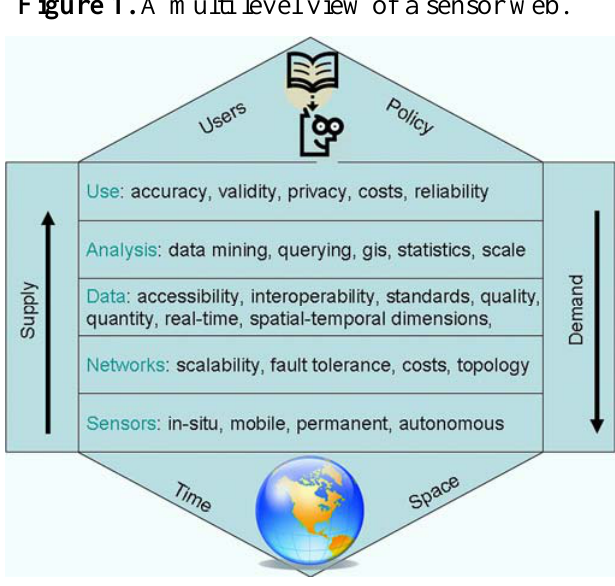
Figure 1. A multi level view of a sensor